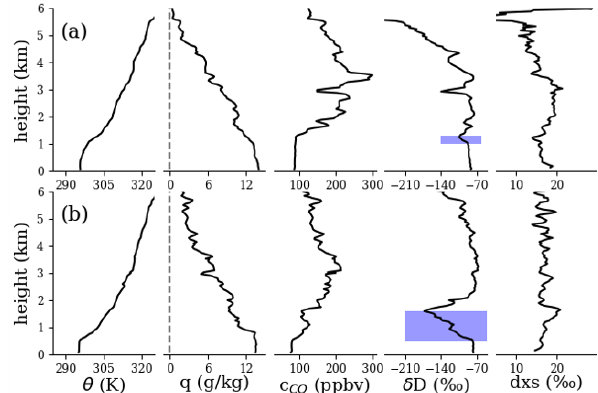
Figure 11. Similar to Fig. 9 but for the 2018 sampling period. Verti- cal profiles taken on (a) 3 October (mean latitude 4.6 ◦ S, mean lon- gitude 5.05 ◦ E, mean time 13:10UTC) and (b) 19 October (7.8 ◦ S, 9.0 ◦ E, 10:30UTC). Blue highlighted regions are discussed in the main text.